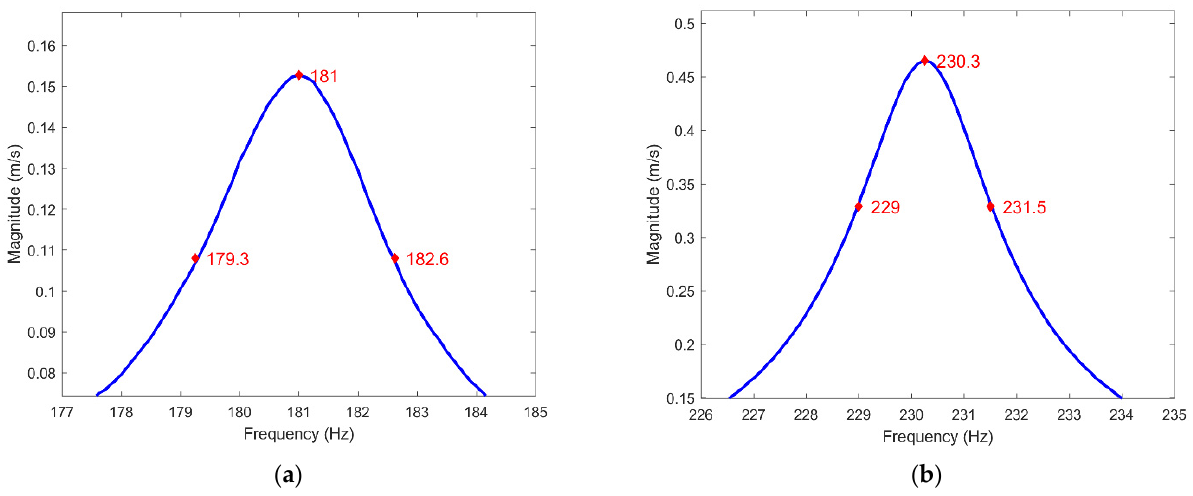
Figure 16. The half-bandwidth method for modal loss factor extraction for ( a ) the fourth mode; ( b ) the fifth mode (see Table 2 for details). Table 4. Determined modal loss factors 𝜂 (cid:3041) , H- for healthy plate and D for plate with delamination.